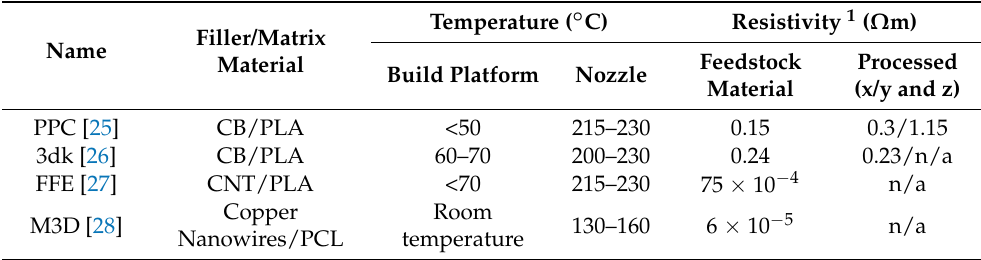
Table 2. Overview of the composite materials used in the experimental investigations with their recommended processing conditions.